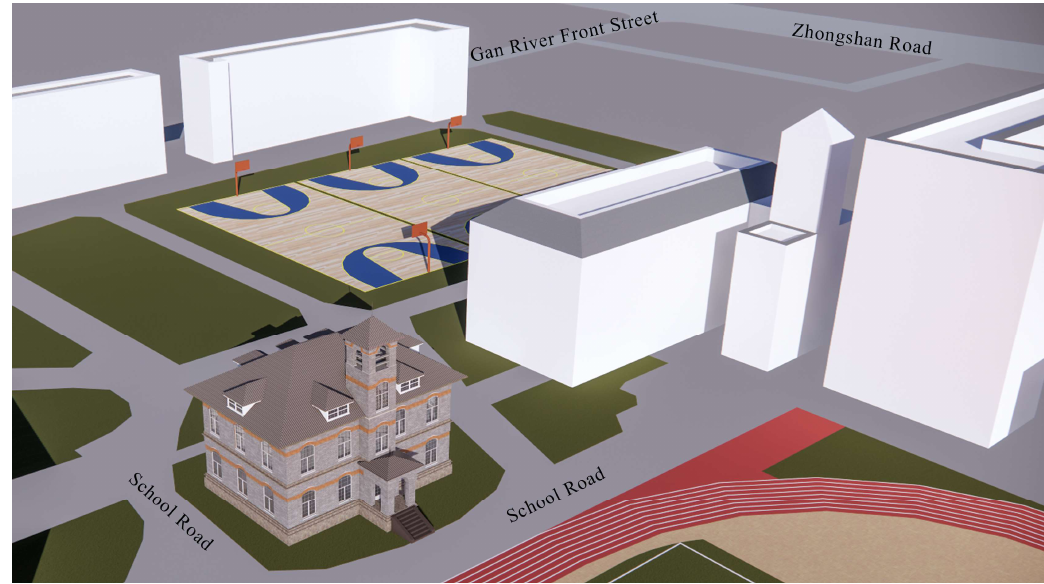
Figure 3. Location of the bell tower on the campus (source: author).